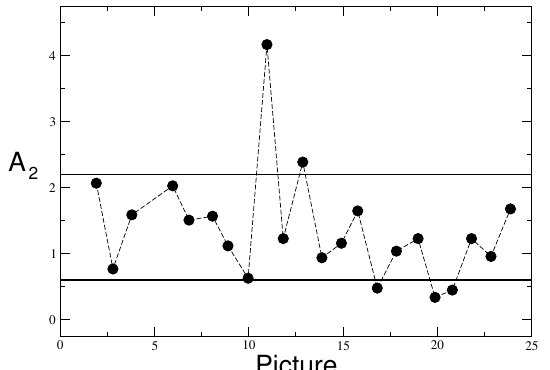
Figure 6. Joos’ second-harmonic amplitudes in units of 10 − 3 . The vertical band between the two lines corresponds to the range ( 1.4 ± 0.8 ) · 10 − 3 . The figure is taken from [37].